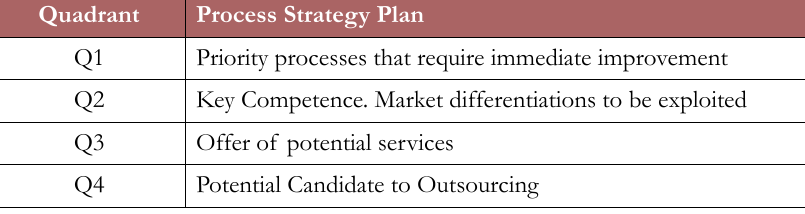
Table 4. Quadrants of classification of the identified processes